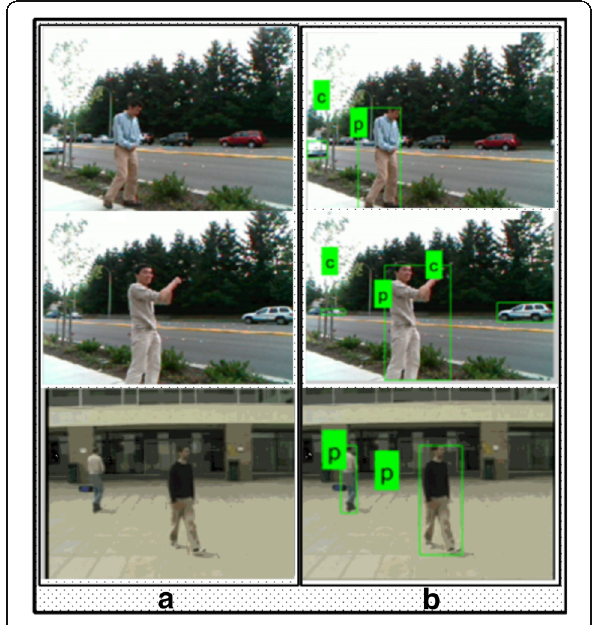
Fig. 1 Proposed human detection and classification results using EPFL and MSRA Action